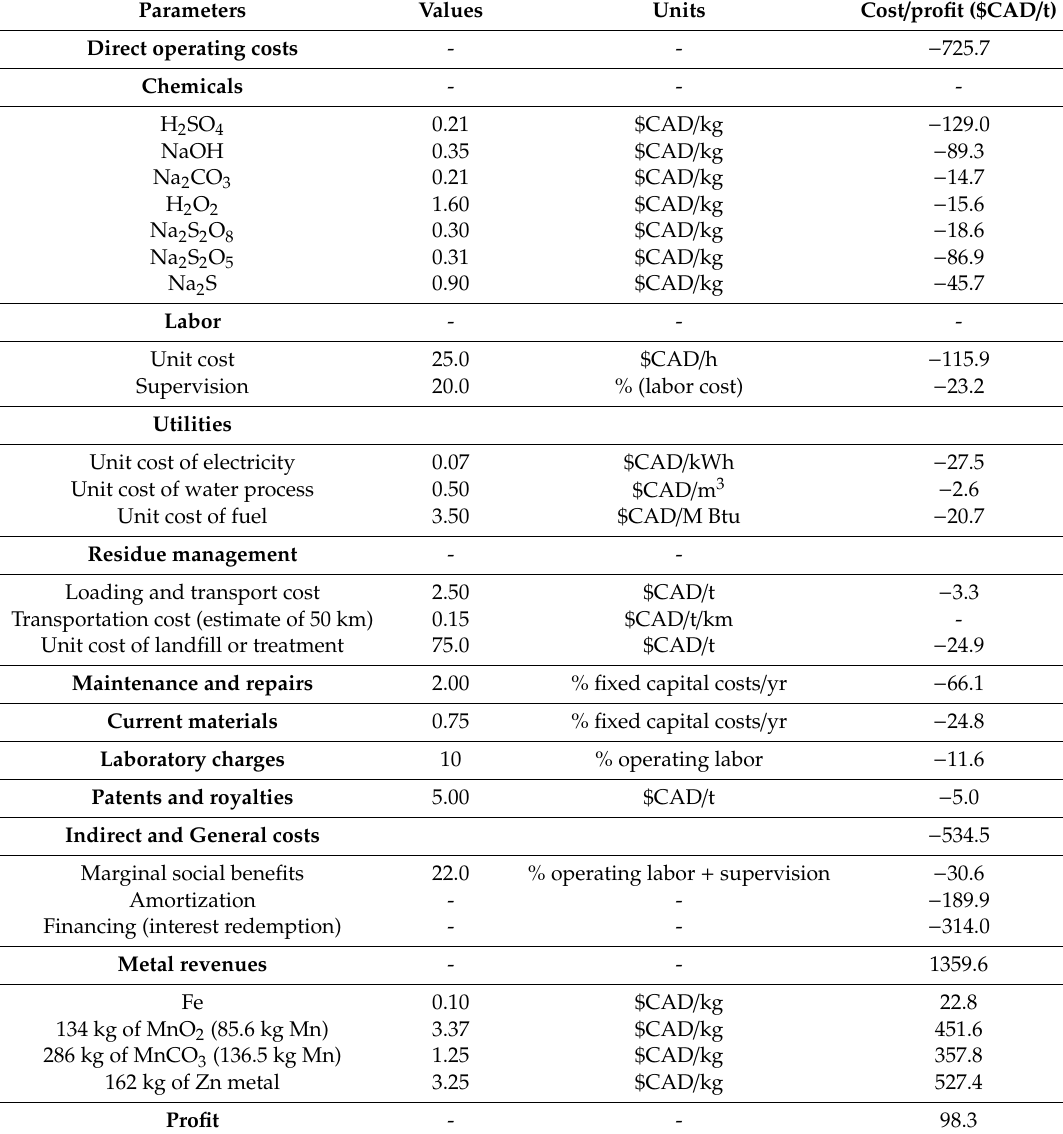
Table 9. Parameters related to hydrometallurgical recovery in spent alkaline